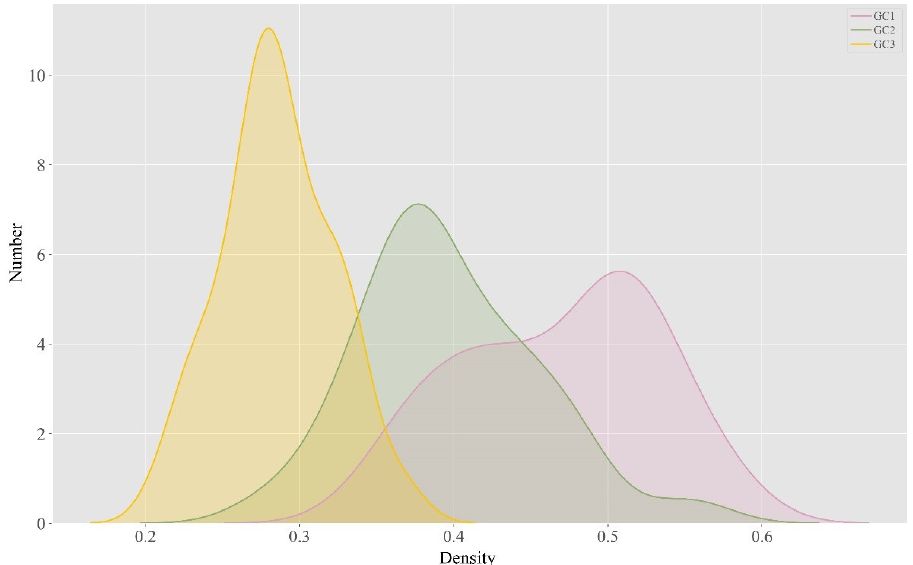
Figure 1. The kernel density curve of GC1, GC2 and GC3. The x-axis represents the density of GC1, GC2 and GC3 contents in all test CDS, and the y-axis indicates the relative quantity.